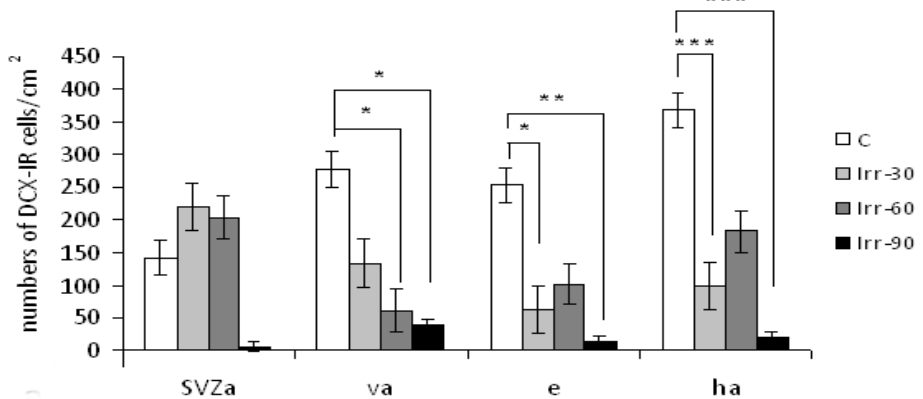
Figure 1. Distribution of DCX immunoreactive (DCX-IR) cells in the anterior horn of the subvetricular zone (SVZa), vertical arm (va), elbow (e), and horizontal arm (ha) in the RMS of control and irradiated adult male rats investigated 30, 60 and 90 days after fractionated irradiation with a total dose of 4 Gy (C, Irr-30, Irr-60, Irr-90; x ± SEM). Statistical significance of differences between control and irradiated group and between the irradiated animals: * p ≤ 0.05; ** p ≤ 0.01; *** p ≤ 0.001.